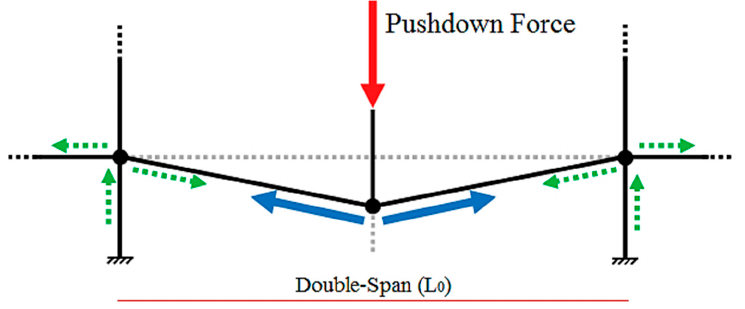
Figure 1. Double-span assembly.